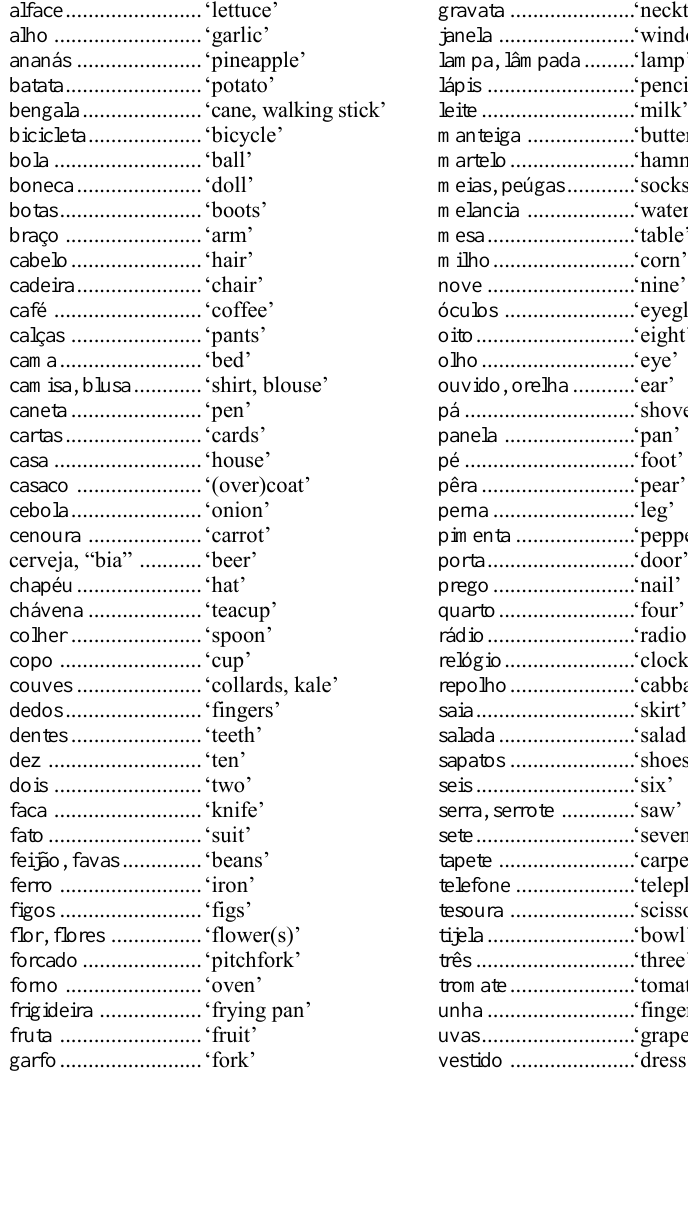
This table lists the lexical items corresponding to the images presented to participants, presented below in alphabetical order. Items with nasalized tonic vowels have been